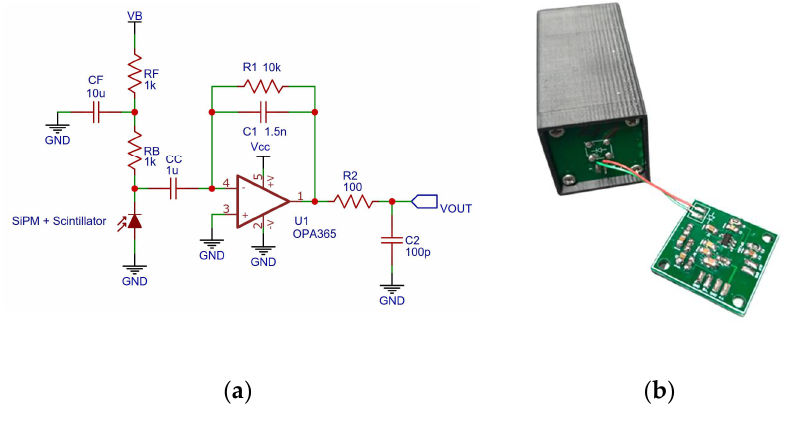
Figure 2. CSA schematic ( a ) and realization ( b ).